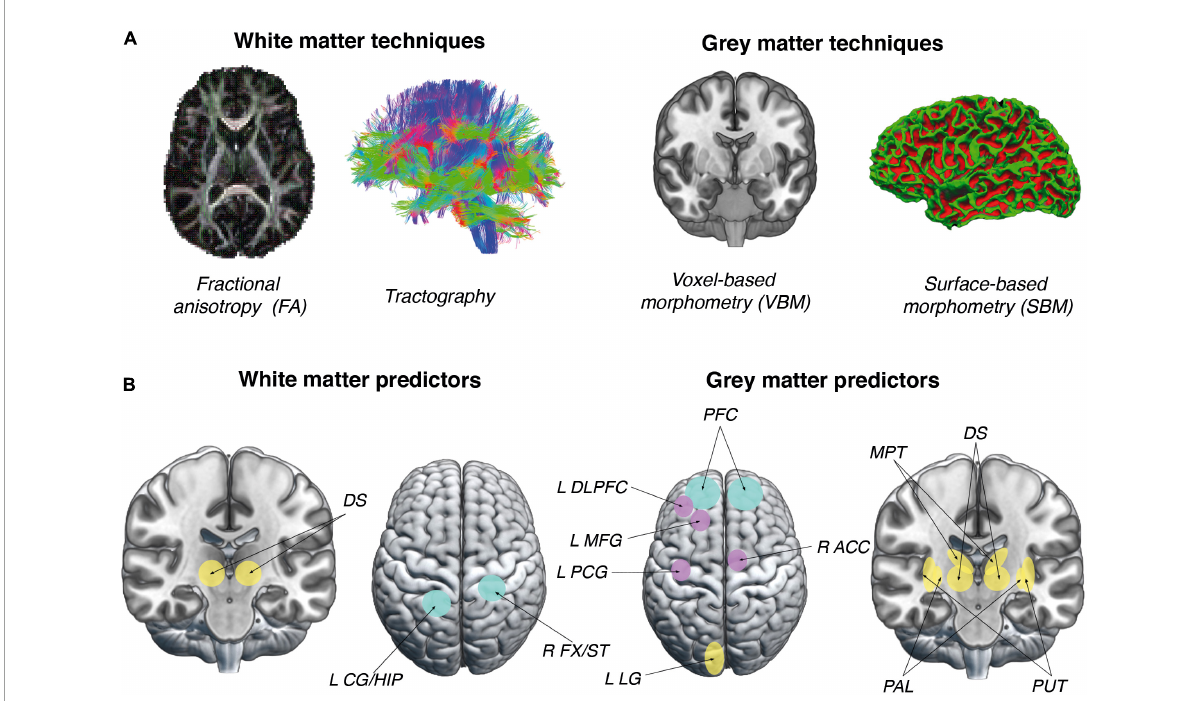
FIGURE1 Approaches and predictors used in studies of complex VG skill acquisition. (A) Possible approaches to studying neuroanatomical predictors of complex VG skill acquisition. Images on the left represent approaches that can be used to discover WM predictors (FA, Tractography). Images on the right represent approaches that yield GM measures (VBM, SBM). (B) Figures in this panel represent significant brain structural predictors of VG complex skill acquisition. Brain regions mostly representative for older adults are marked in purple, younger adults in yellow and both groups in turquoise. Mainly cortical areas predicted VG skill acquisition in the group of older adults and subcortical in the group of younger adults. Figures on the left represent properties of WM in brain areas which were found to be significant predictors of VG performance: DS, dorsal striatum (Vo et al., 2011); L CG/HIP, left cingulum/hippocampus; and R FX/ST, right fornix/stria terminalis (Ray et al., 2017). Figures on the right represent properties of GM in brain areas which were found to be significant predictors of VG performance: DS, dorsal striatum (Erickson et al., 2010); MPT, medial-posterior thalamus (Momi et al., 2019); L LG, left lingual gyrus (Momi et al., 2018); PAL, pallidum; PUT, putamen (Kowalczyk-Grêbska et al., 2021), L DLPFC, left dorsolateral prefrontal cortex; L MFG, left medial frontal gyrus; L PCG, left post central gyrus; R ACC, right anterior cingulate cortex (Basak et al., 2011); and PFC, prefrontal cortex (Head et al., 2002). Brain images were created with MRIcroGL, an open-source 3D-rendering software package (McCausland Center for Brain Imaging, University of South Carolina; https://www.nitrc.org/projects/mricrogl/) and FreeSurfer software (Laboratory for Computational Neuroimaging at the Athinoula A. Martinos Center for Biomedical Imaging;